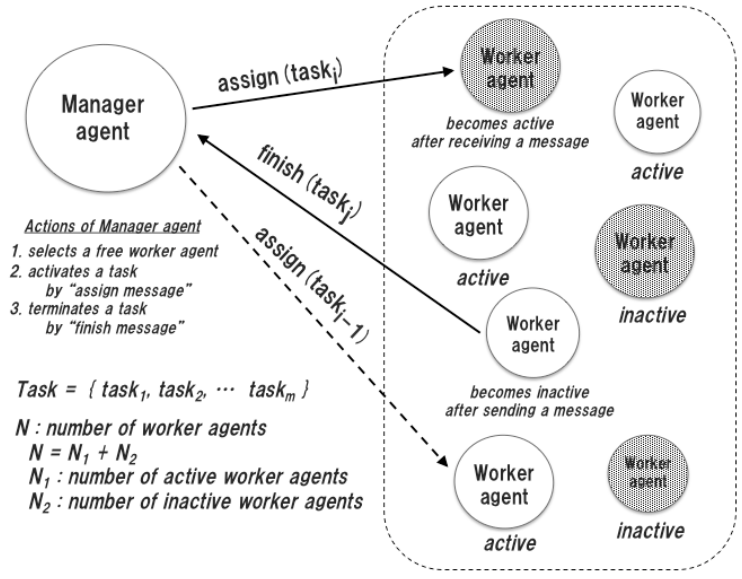
Figure 5. Structure of the test bed system.